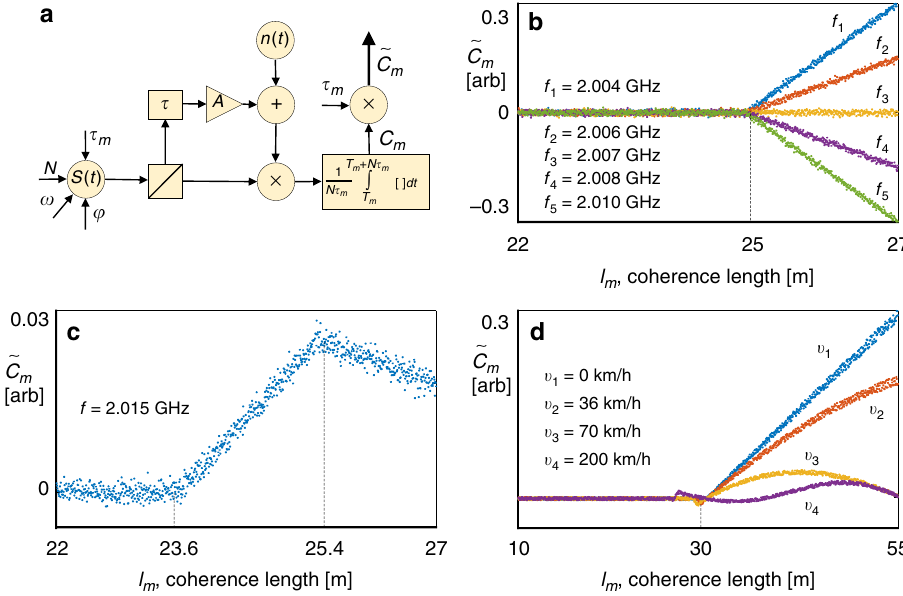
Fig. 3 Simulation results and schematics. a Schematic representation of the partially coherent radar operation. A continuous wave signal is generated with N phase jumps that are randomly produced to provide a constant (controllable) coherence time τ m (time between phase switching events). Each pulse has a random phase ( φ n or vector (cid:2) φ ), which is kept constant for the pulse duration. The signal re fl ects from a target that is situated at a distance related to the delay, attenuated by a factor A and received along with additive white noise. The output of the receiver is mixed with the still transmitting signal and averaged over the duration of the transmission time N τ m (the averaging starts at the same time as the signal begins transmitting). The result of the integration is multiplied by the coherence time τ m . The result is termed the cross-correlation and denoted as ~ C m . The process is repeated for M coherence points (lengths of constant coherence). M and N de fi ne the performances of the system (range resolution and range accuracy). Monte Carlo simulations in high SNR (30 dB) scenarios: b Cross-correlation as a function of coherence length for a single target located 25 away, drawn for different carrier frequencies using Eq. (4). c Cross-correlation for two targets located at coherence lengths of 23.6 and 25.4 corresponding to Eq. (9). d Cross-correlation of a single target moving at different velocities along the line of sight, corresponding to Eq. (14)